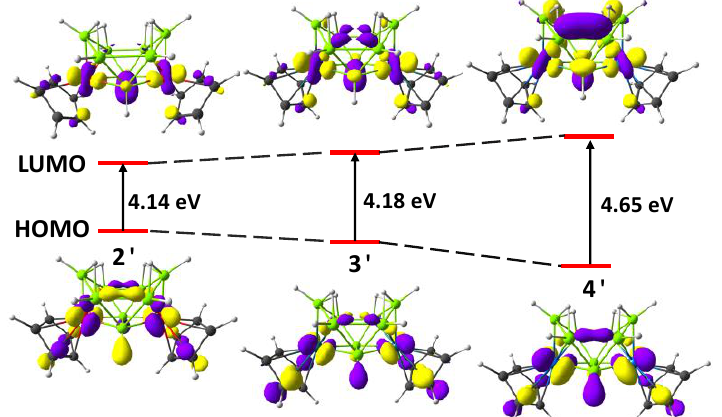
Figure 6. Frontier molecular orbital diagram of 2′ , 3′ , and 4′ (see text). Contour value: ±0.05 [e/bohr 3 ] 1/2 .